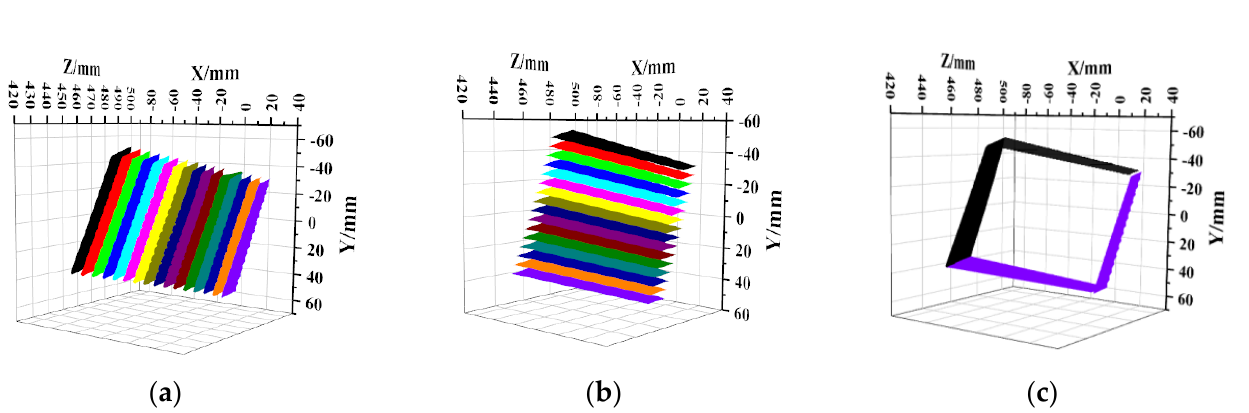
Figure 14. The multiple light planes in the camera coordinate system. ( a ) Vertical light planes. ( b ) Horizontal light planes. ( c ) Space enclosed by the light planes.